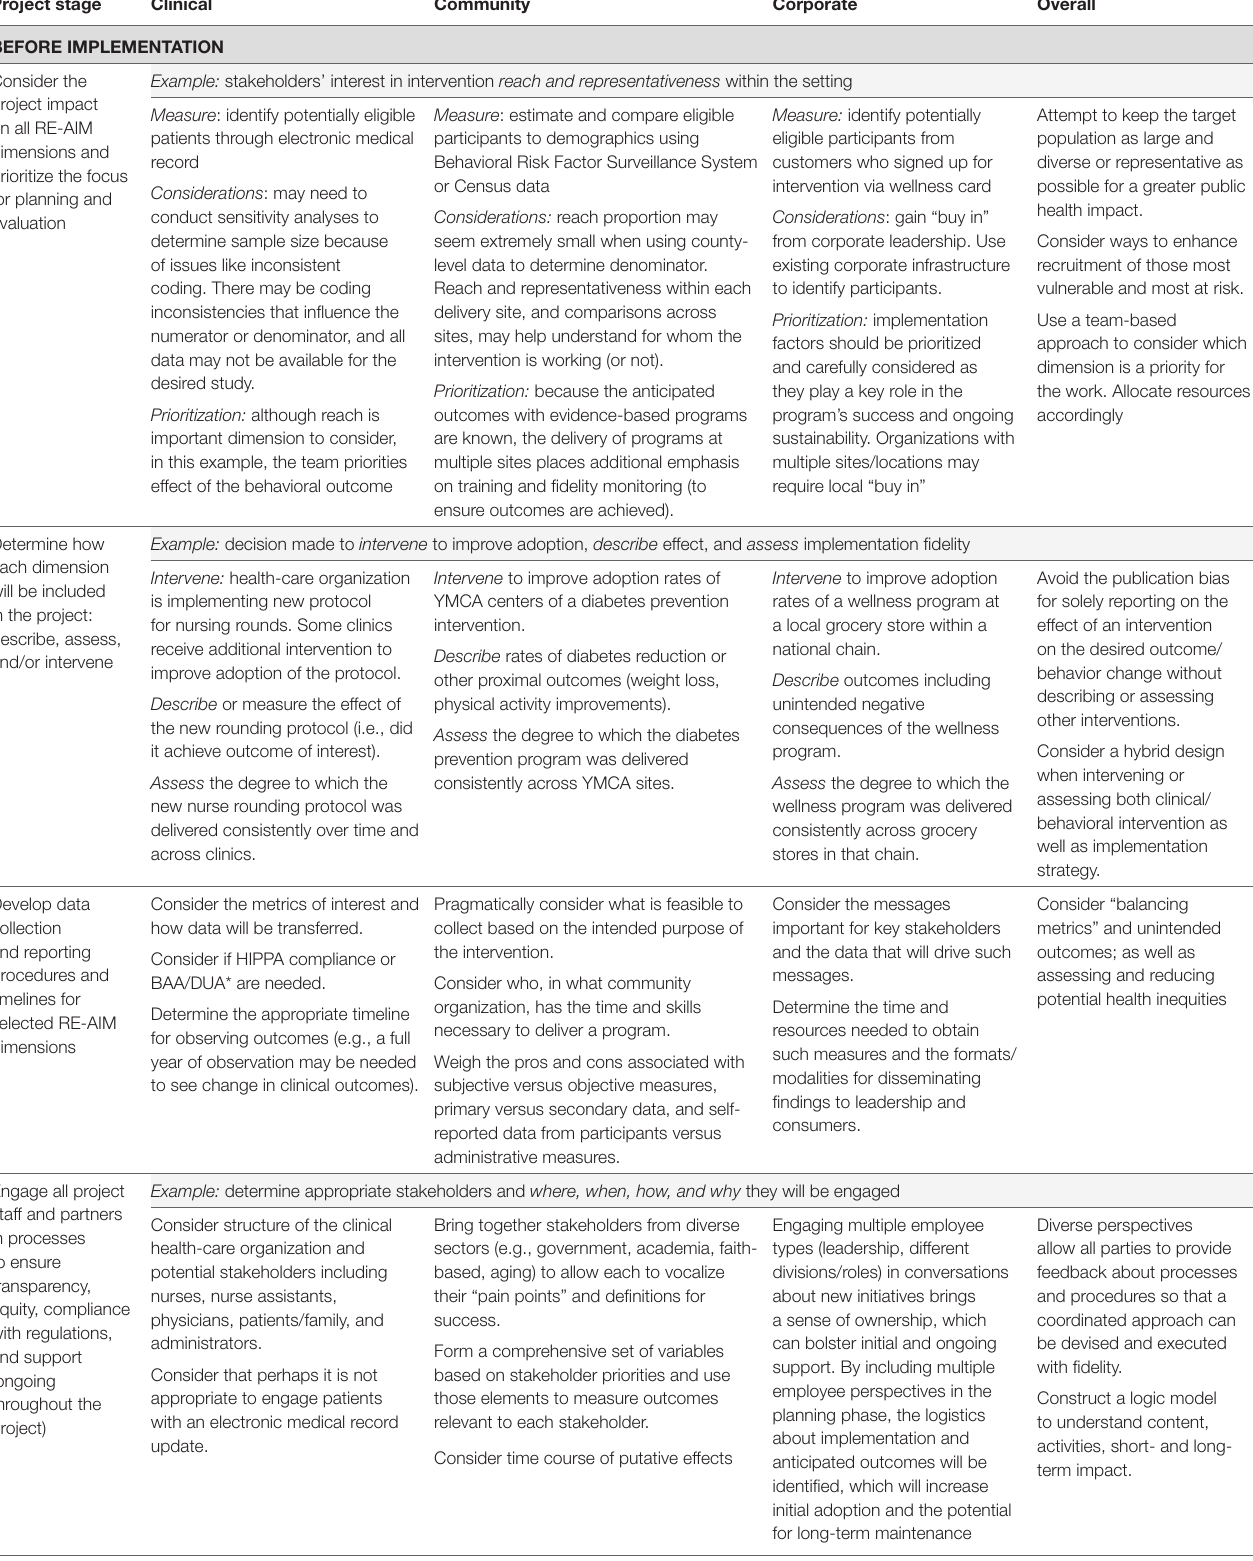
tAbLe 1 | Examples of applying RE-AIM dimension(s) in different settings across different phases of